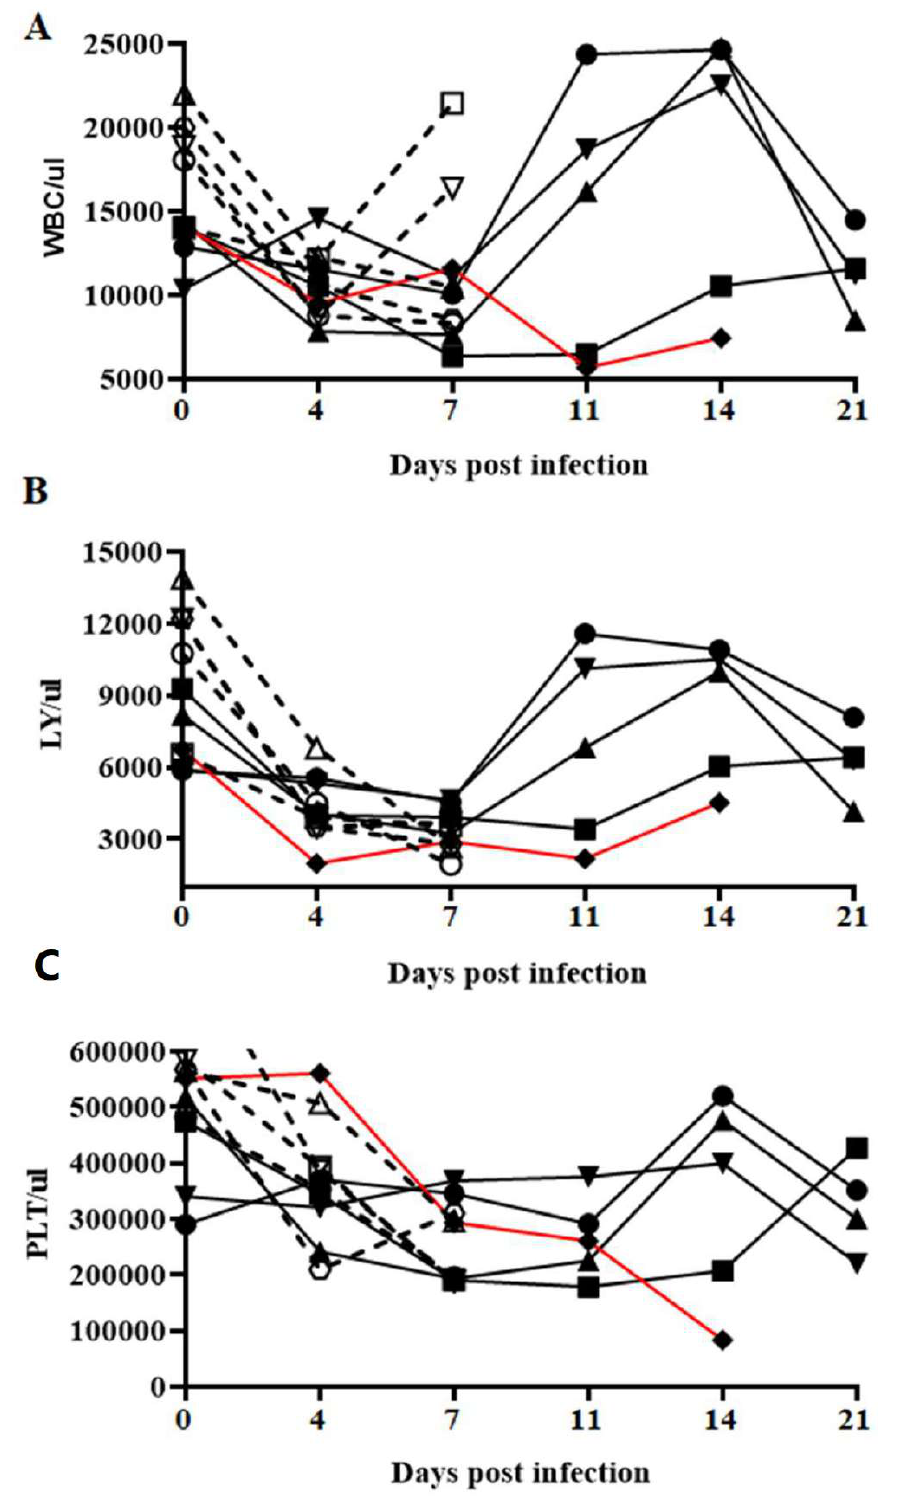
Figure 5. The concentrations of circulating white blood cells ( A ), lymphocytes ( B ) and platelets ( C ) in animals IN infected with 10 5 TCID 50 of either E2 ∆ SERTAD1v (filled symbols) or parental BICv (open symbols). Animals were monitored for an observational period of 21 days post infection. In red is the evolution of the cell values of the only E2 ∆ SERTAD1v-infected animal euthanized at 14